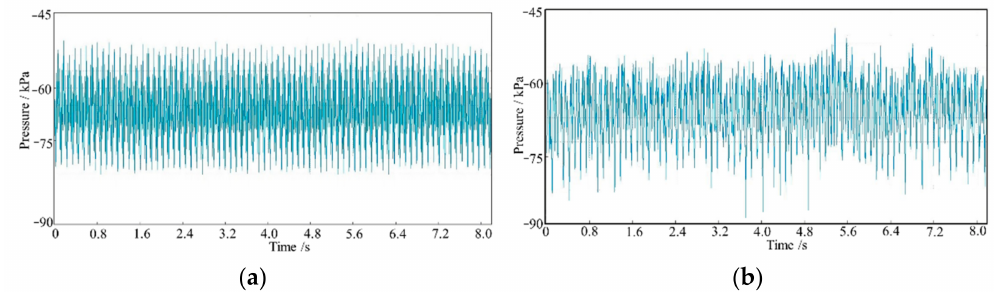
Figure 16. The change curve of instantaneous pressure at the impeller inlet. ( a ) With FAV and ( b ) without